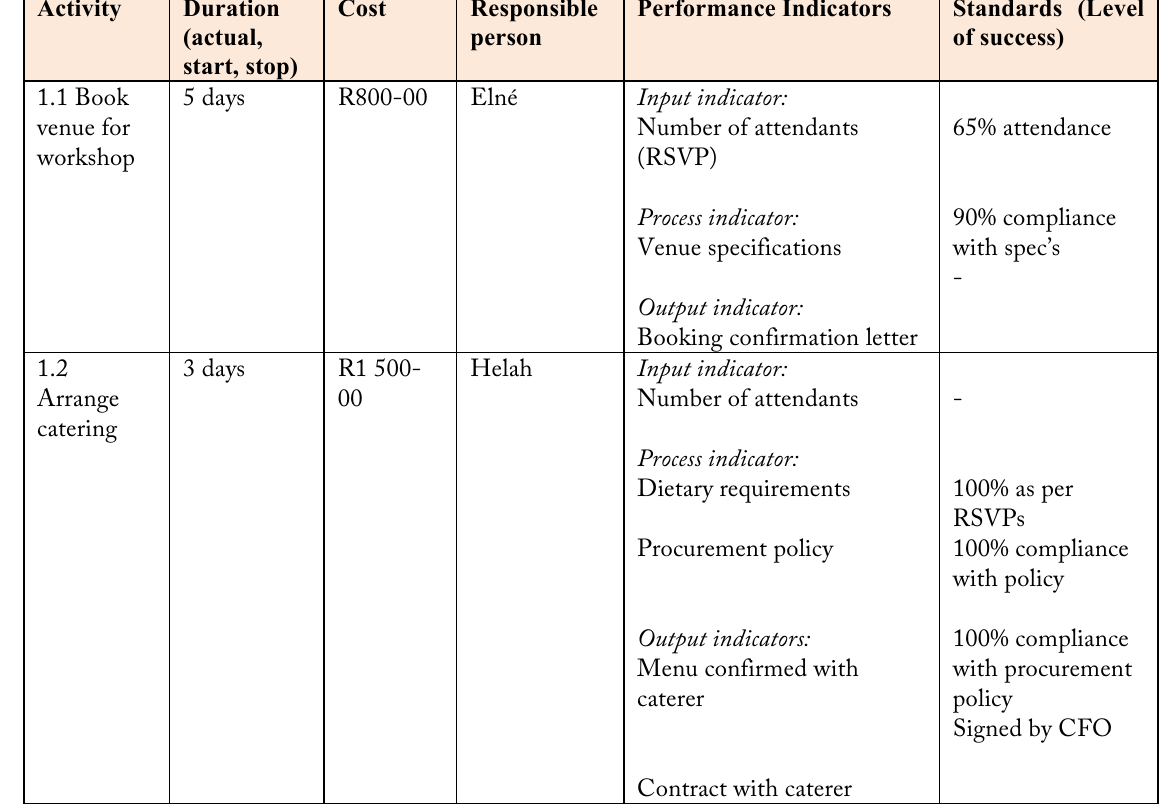
Table 1: Project planning and performance management interface